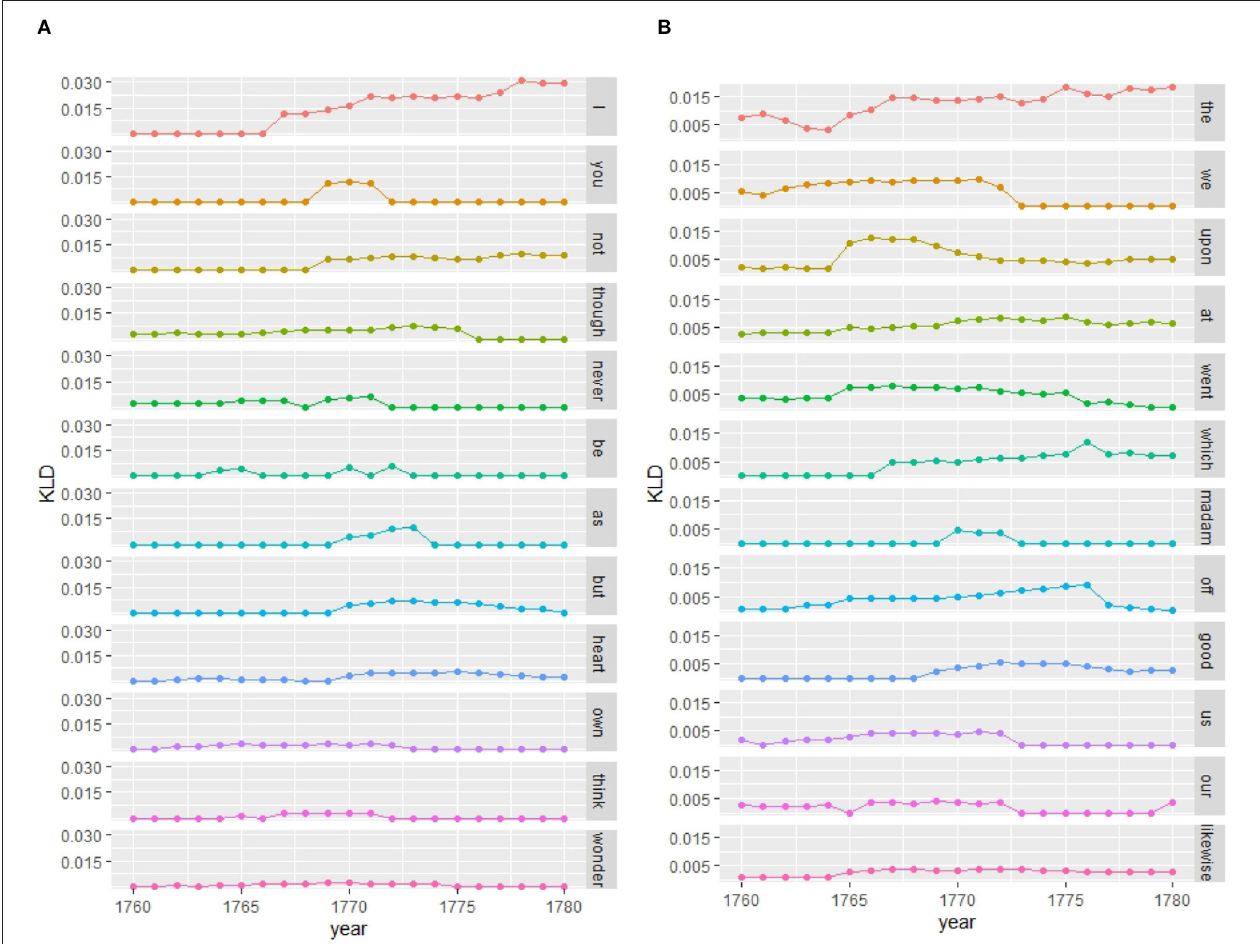
FIGURE 7 | Features contributing to period of change (from top to bottom showing highest to lowest contribution)—contemporary model women vs. men (word-unigram). (A) Women. (B)